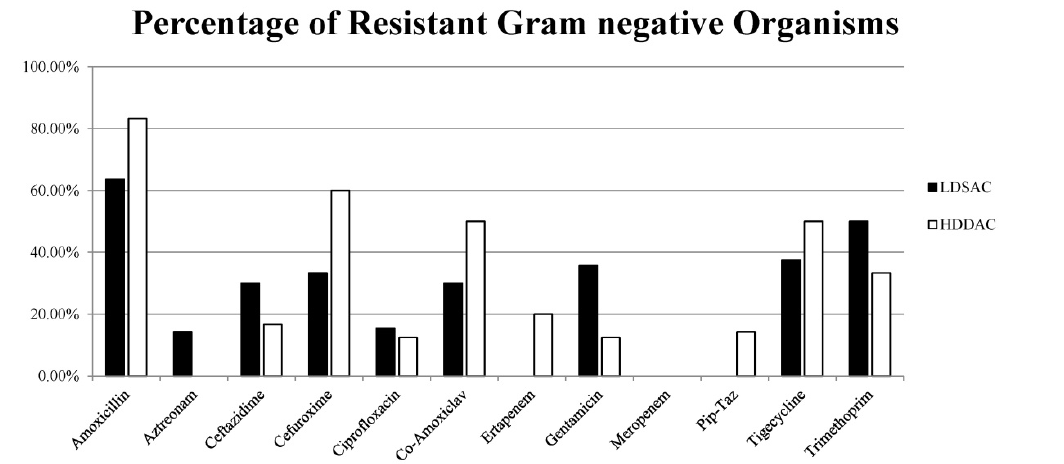
Figure 3. Resistance in Gram negative